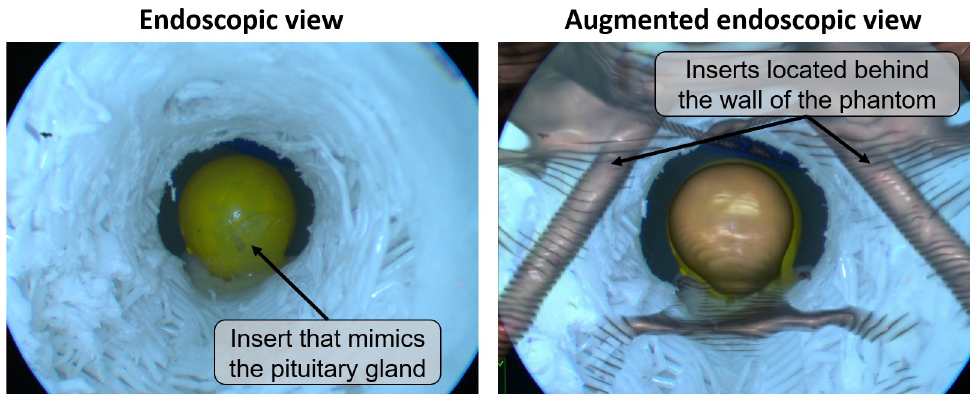
Fig 6. Example of image fusion on the endoscopic